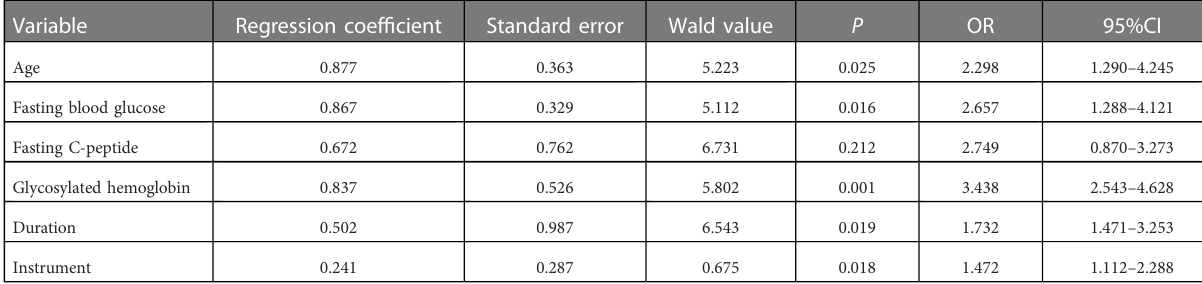
TABLE 4 Multi-factor logistic regression analysis.